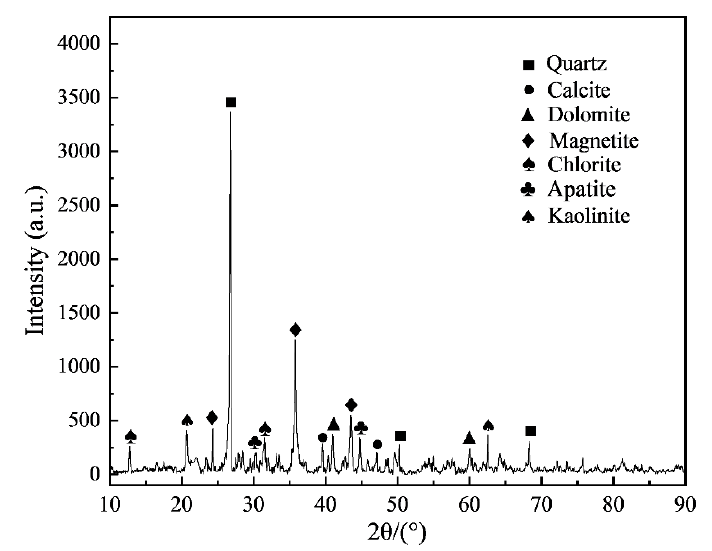
Figure 5. XRD patterns of the tailings.